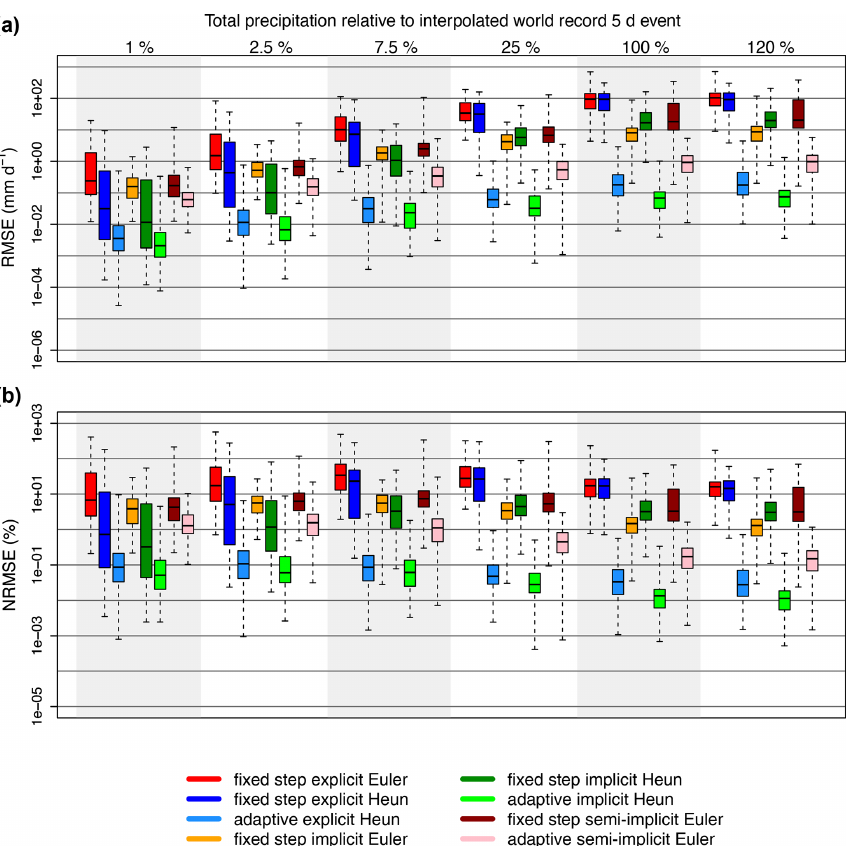
Figure 7. Box plots showing the errors (RMSE shown in a and NRMSE shown in b ) associated with each numerical technique for 5d precipitation events of variable intensity with increasing total precipitation, where the total precipitation is represented as a percentage of the interpolated world record 5d event total precipitation. The solid black line in each box is the median error, the boxes extend to the 25% and 75% quantiles, and the whiskers extend to extreme values. All adaptive methods use the FUSE default error tolerances. The model runs represented in this figure are generated across 20 parameter sets, five model structures, and three spin-up conditions. Note that errors are generally larger than in the case where the precipitation signals have no variance per